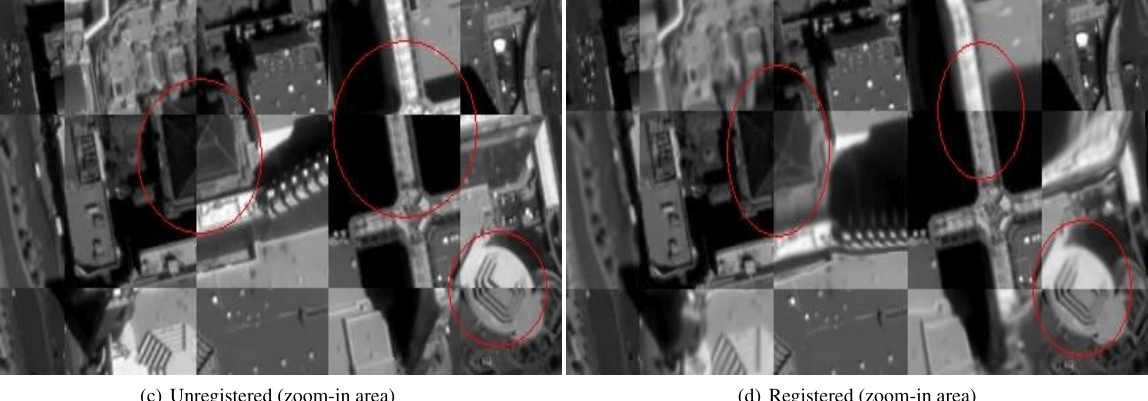
Figure 2: Chessboard visualizations from the Las Vegas Skybox dataset. Frames from the unregistered dataset (a) and frames after the registration process (b) are shown in the first two rows. Zoom-in areas are shown in the third row for the unregistered (c) and registered (d)